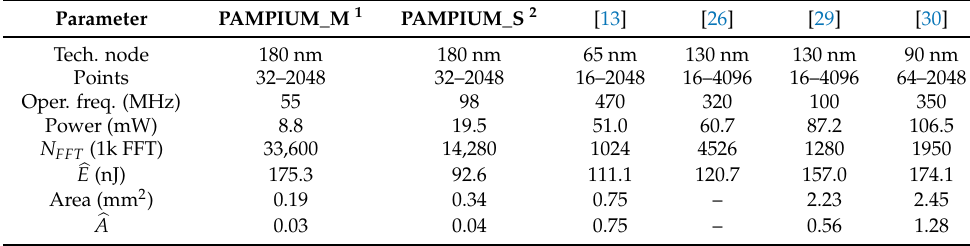
Table 6. Physical synthesis results for the ASIP implementation of the FFT